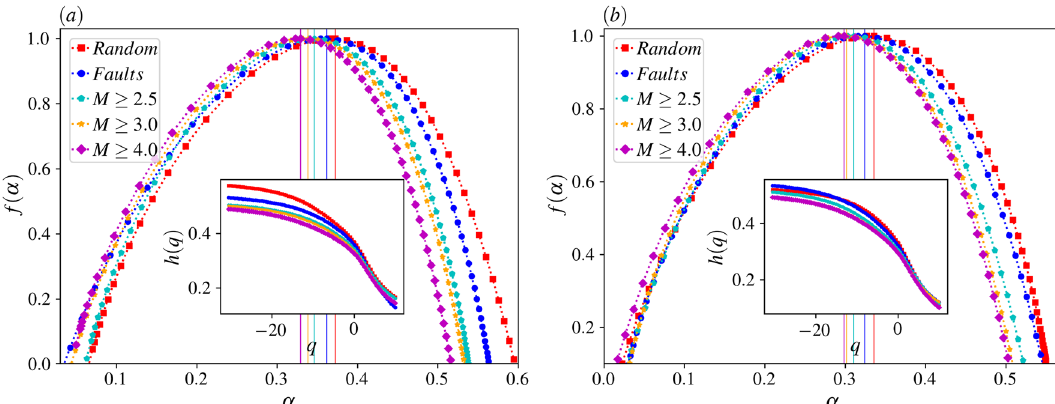
Figure 11. ( a ) Main panel: f (α) vs. α for various dynamics for the dynamics with avalanches in the whole space. inset: h ( q ) vs. q for various dynamics. ( b ) The same for the dynamics with avalanches inside the high- resolution box.